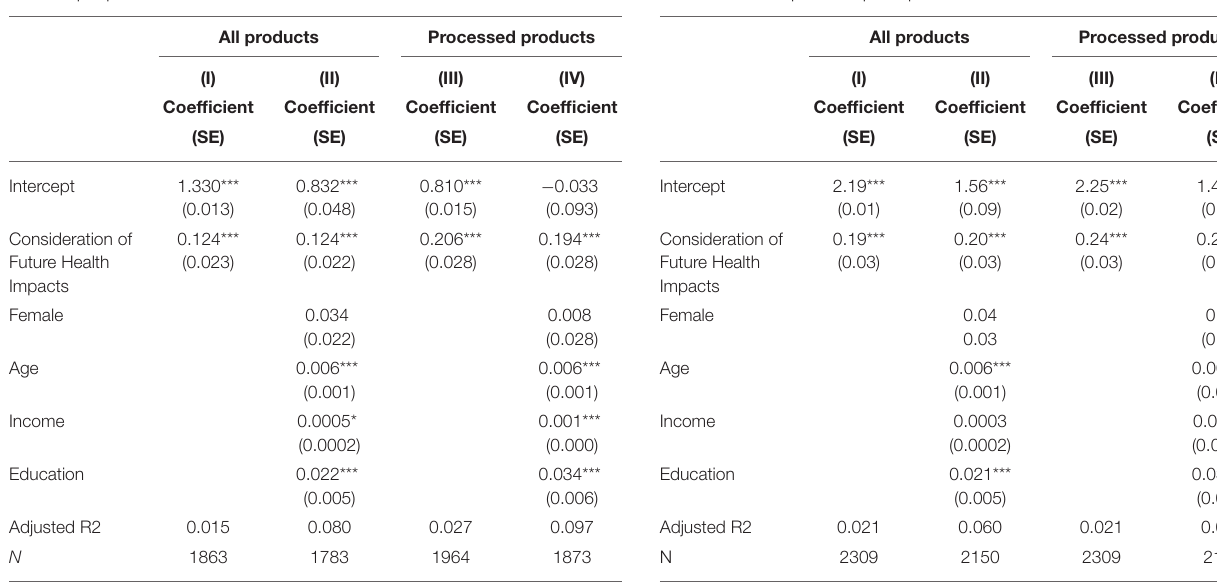
TABLE 2 | The impact of consideration of future health on average guiding stars selected per product in control condition.